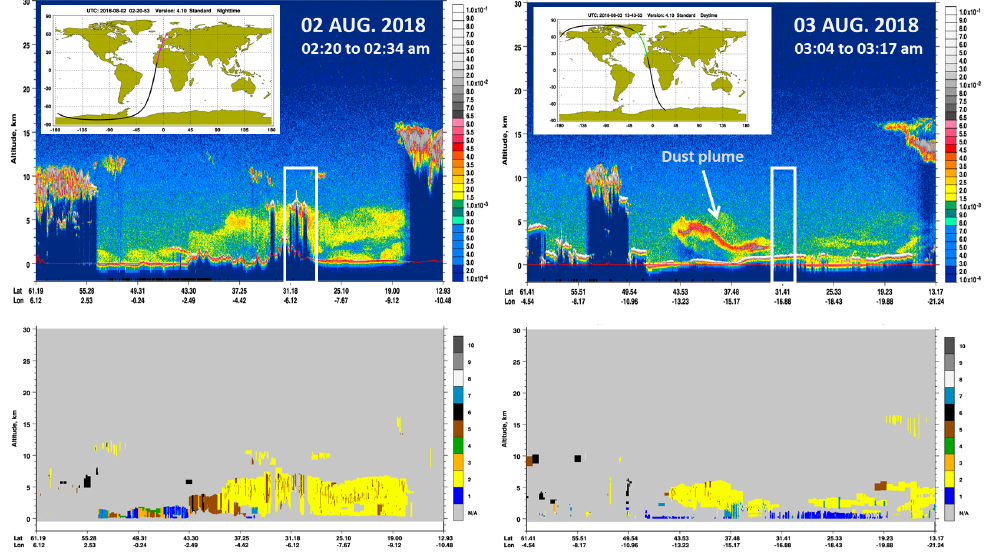
Figure 7. CALIOP total attenuated backscatter (km − 1 · sr − 1 ) at 532-nm on the upper panels, and aerosol subtype classifications for the same scenes, respectively, observed on 2 and 3 August 2018. The CALIPSO ground track is overlaid in the upper-left corner of panels. The white boxes highlight the nearest CALIPSO flight over the study site. The colours in the subtype im- ages are numbered from 1 to 7 and depict the observed aerosol type: 1 (blue) = clear marine, 2 (yellow) = dust, 3 (orange) = polluted continent, 4 (green) = clean continent, 5 (brown) = polluted dust, 6 (black) = smoke, 7 (light blue) =